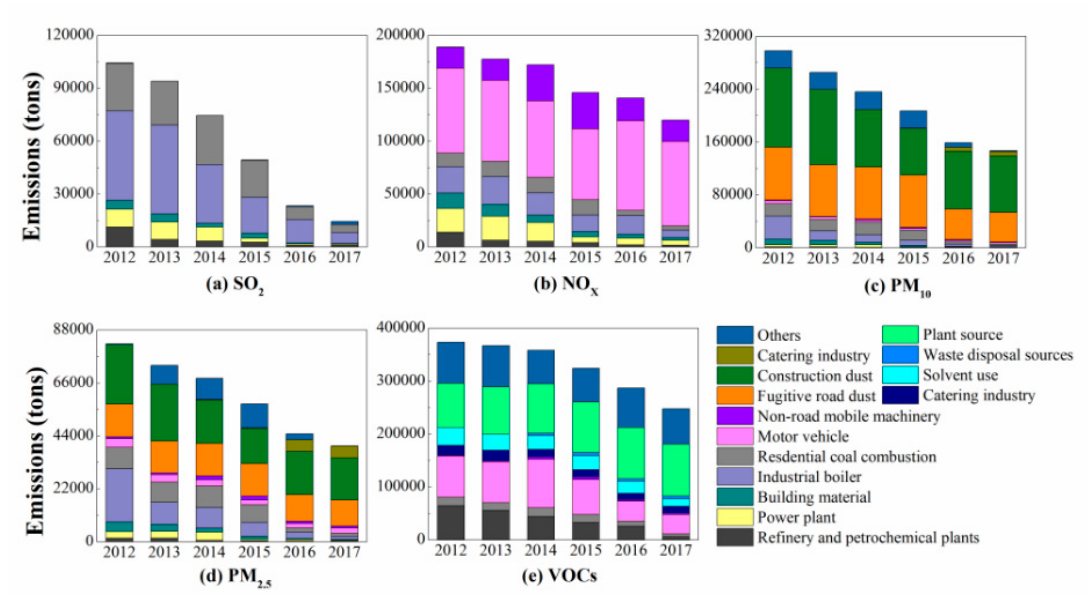
Figure 4. Emission variation of air pollutants from 2012 to 2017. SO 2 ( a ), NO x ( b ), PM 10 ( c ), PM 2.5 ( d ) and VOCs ( e ).